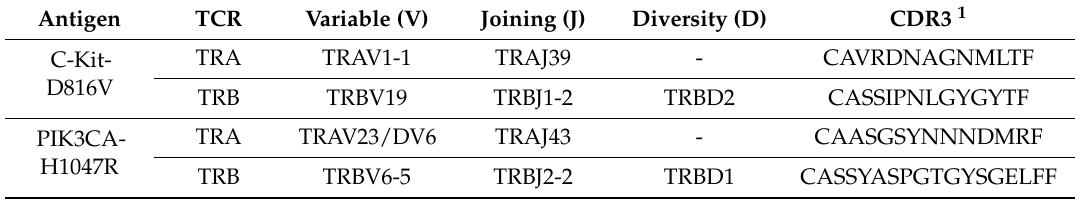
Table 3. T cell receptor (TCR) sequences of T cell clones specific to PIK3CA-H1047R and C-Kit-D816V. Antigen